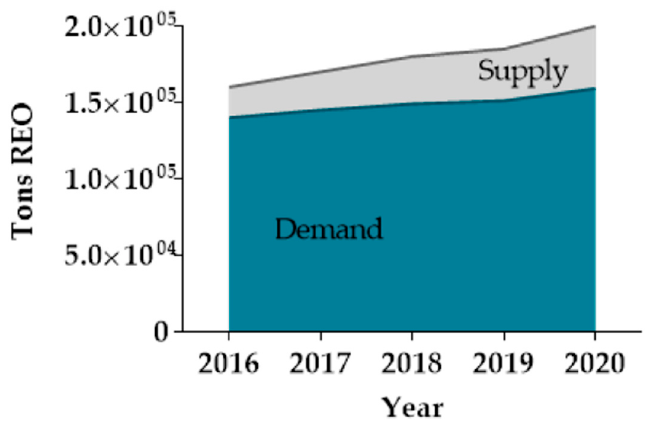
Figure 4. Evolution of global REE demand and supply from 2016 to 2020. Data obtained from [24].